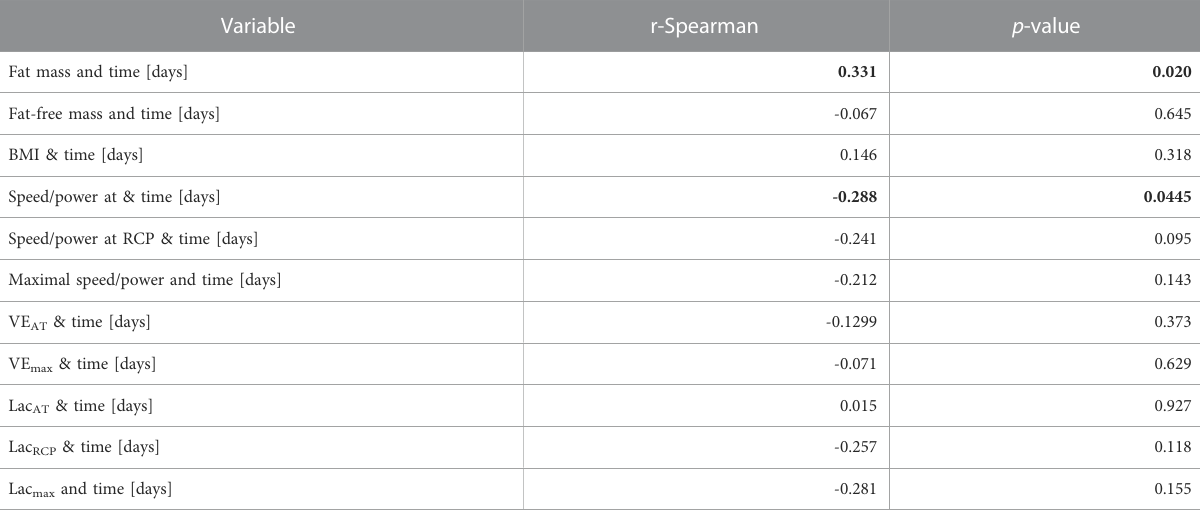
TABLE 6 Spearman ’ s rank correlation coef fi cient for CPET and physiologic results adjusted to the